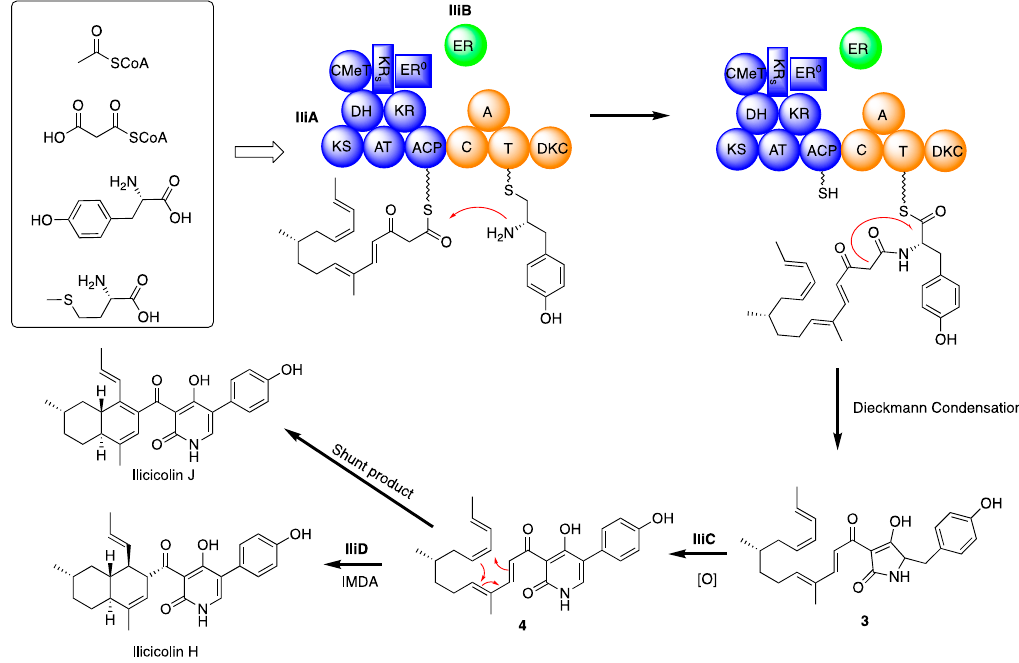
Figure 4. Proposed biosynthetic pathway for ilicicolin H and ilicicolin J.